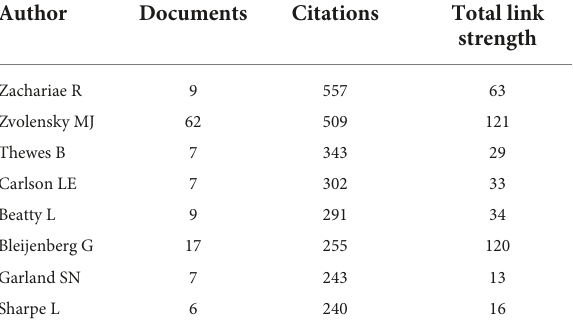
TABLE 5 Top 8 authors with the most times cited of their publications in the research scope of cognitive behavioral therapy and cancer.